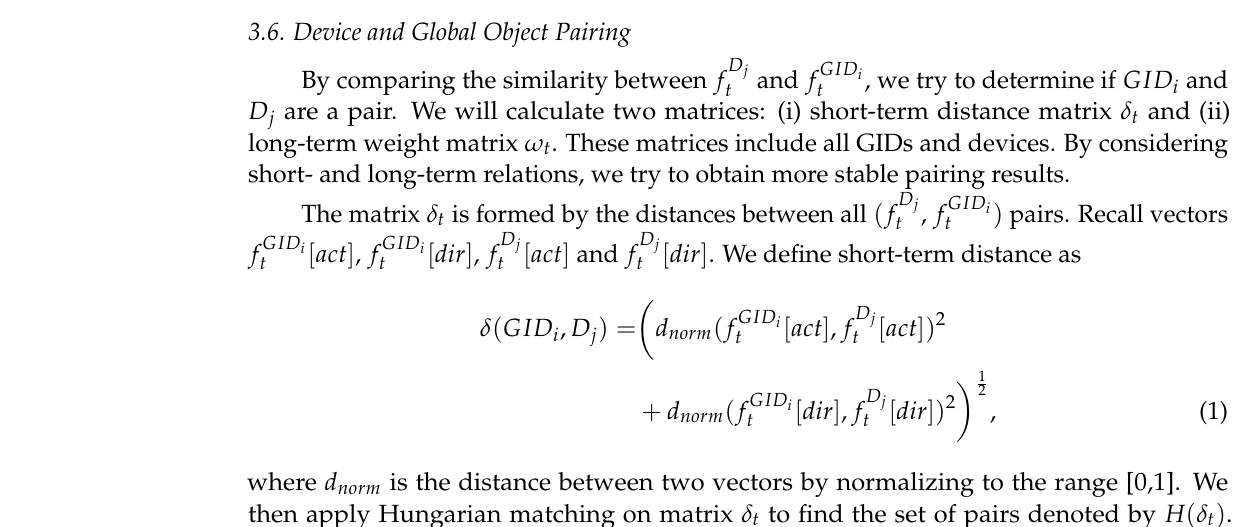
Figure 5. Feature extraction procedure for GID i and D j .